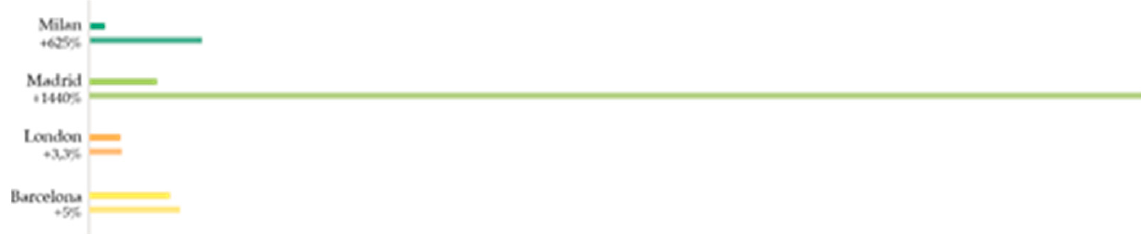
Figure 2. Actual green coverage per km 2 in 2020 vs. future green coverage per km 2 in 2030.